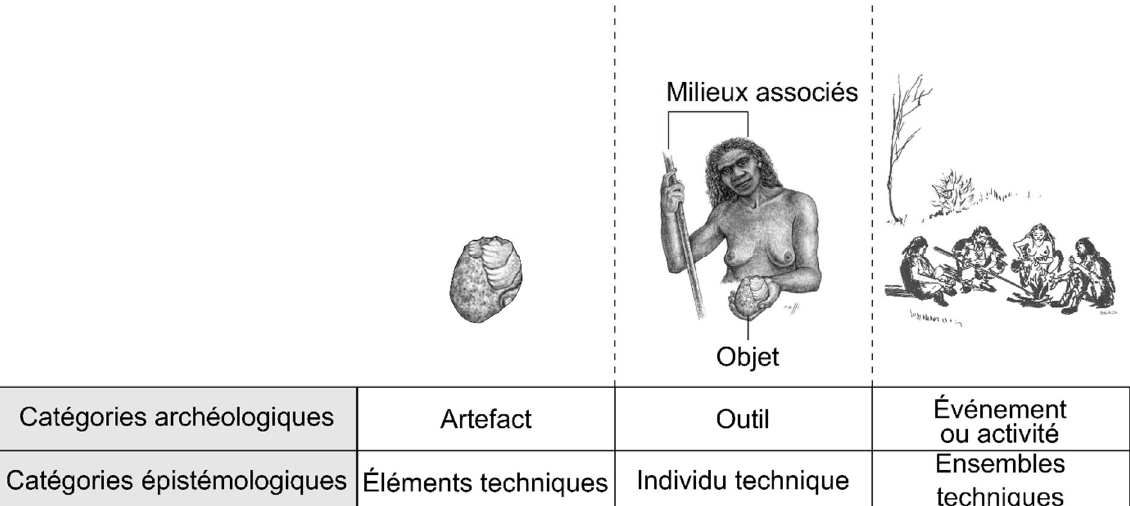
Figure 5. Corrélation conceptuelle entre les catégories archéologique et épistémologique mobilisées dans le présent travail. Les dessins ont été réalisés par Maxence Raffi, et Aurore de